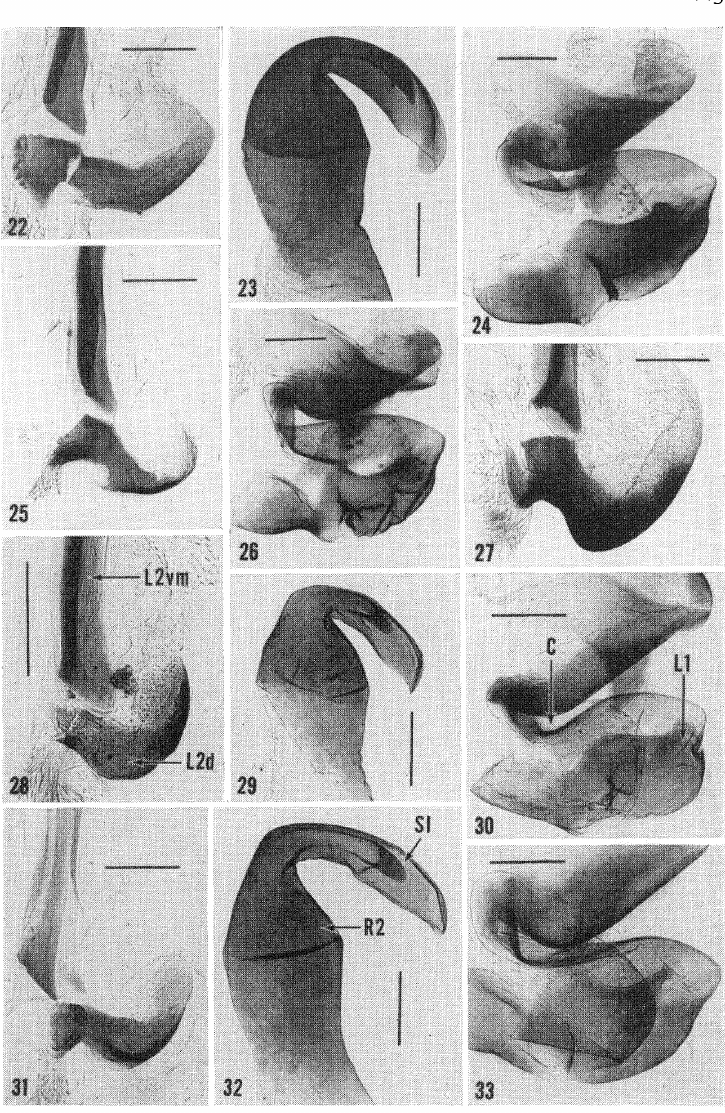
Figs. 22-33. 22-24. (179 USNM). Zetobora sitTnaticollis. Santo Amaro, Silo Paulo, Brazil. (det. Gurney). 25-26. (180 USNM). Z. signaticollis. Santo Amaro, Silo Paulo, Brazil. 27. (181 USNM), Zetobora sp. Serra ---- Caraga, M. G. Brazil. 28-30. (6 BMNH), Zetobora transersa. (from adult shown in Fig. 2). 31-33. (7 BMNH). Zetobora monastica. (from adult shown in Fig. 4). L1 first selerite of left phallomere; C "--" deft of El; ---- L2vm median selerite (L2 ventromedial) L2d dorsal selerite of L2; R2 hooked selerite of right phallomere; SI subapieal incision of R2. (scale 0.2